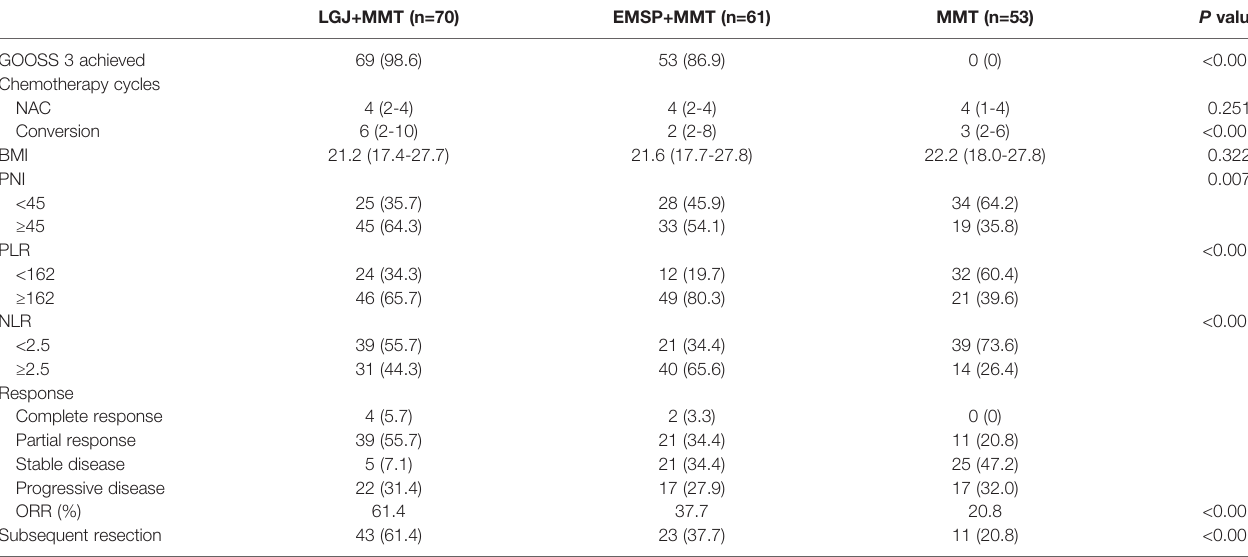
TABLE 2 | Clinical outcomes after treatment models.